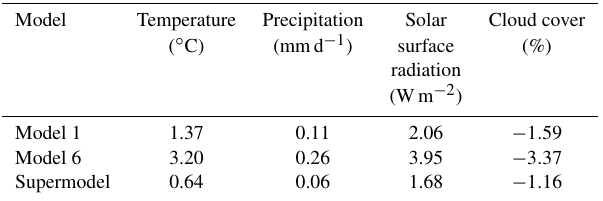
Table 6. Global mean average difference with the perfect model, calculated over the last 30 years of the